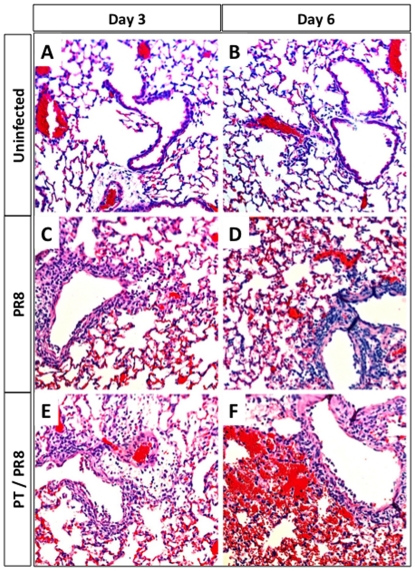
Histopathological examination of lungs from PT-treated and control mice infected with influenza virus.Lung sections of BALB/c mice inoculated with 100 ng of PT or with PBS and infected with influenza PR8 (600 PFU) 24 h later. Sections were prepared from (A–B) uninfected mice, or 3 and 6 days after virus inoculation from (C–D) PBS-treated or (E–F) PT-treated mice. Lungs were harvested and fixed immediately in 4% formalin. Sections were stained with hematoxylin-eosin and evaluated for density and location of cellular infiltrates. Sections include representative results from 3 mice/time point. Original magnification 10×. n = 3 mice/treatment group.